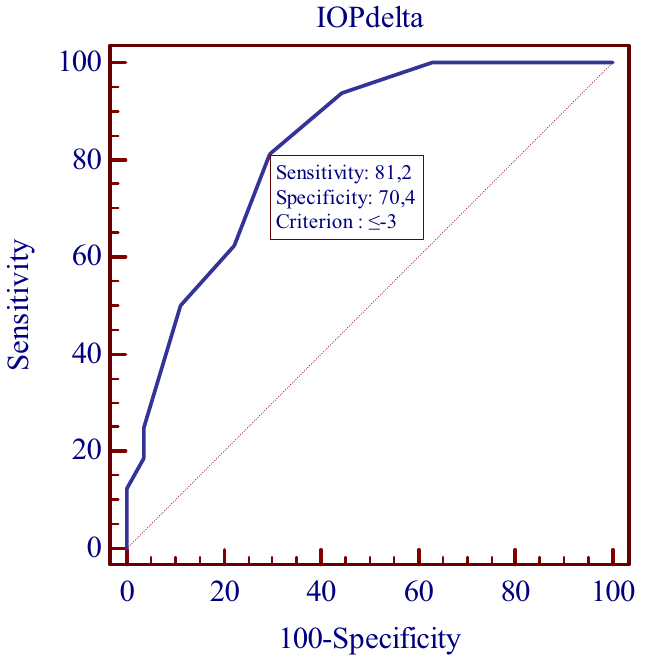
Figure 3. ROC analysis. IOP cut-off value was < − 3.0 mmHg. Sensitivity 81.2%, Specificity 70.4% Area under ROC curve 82.9%. (Illustration made using IBM SPSS Statistics for Windows, Version 23.0).